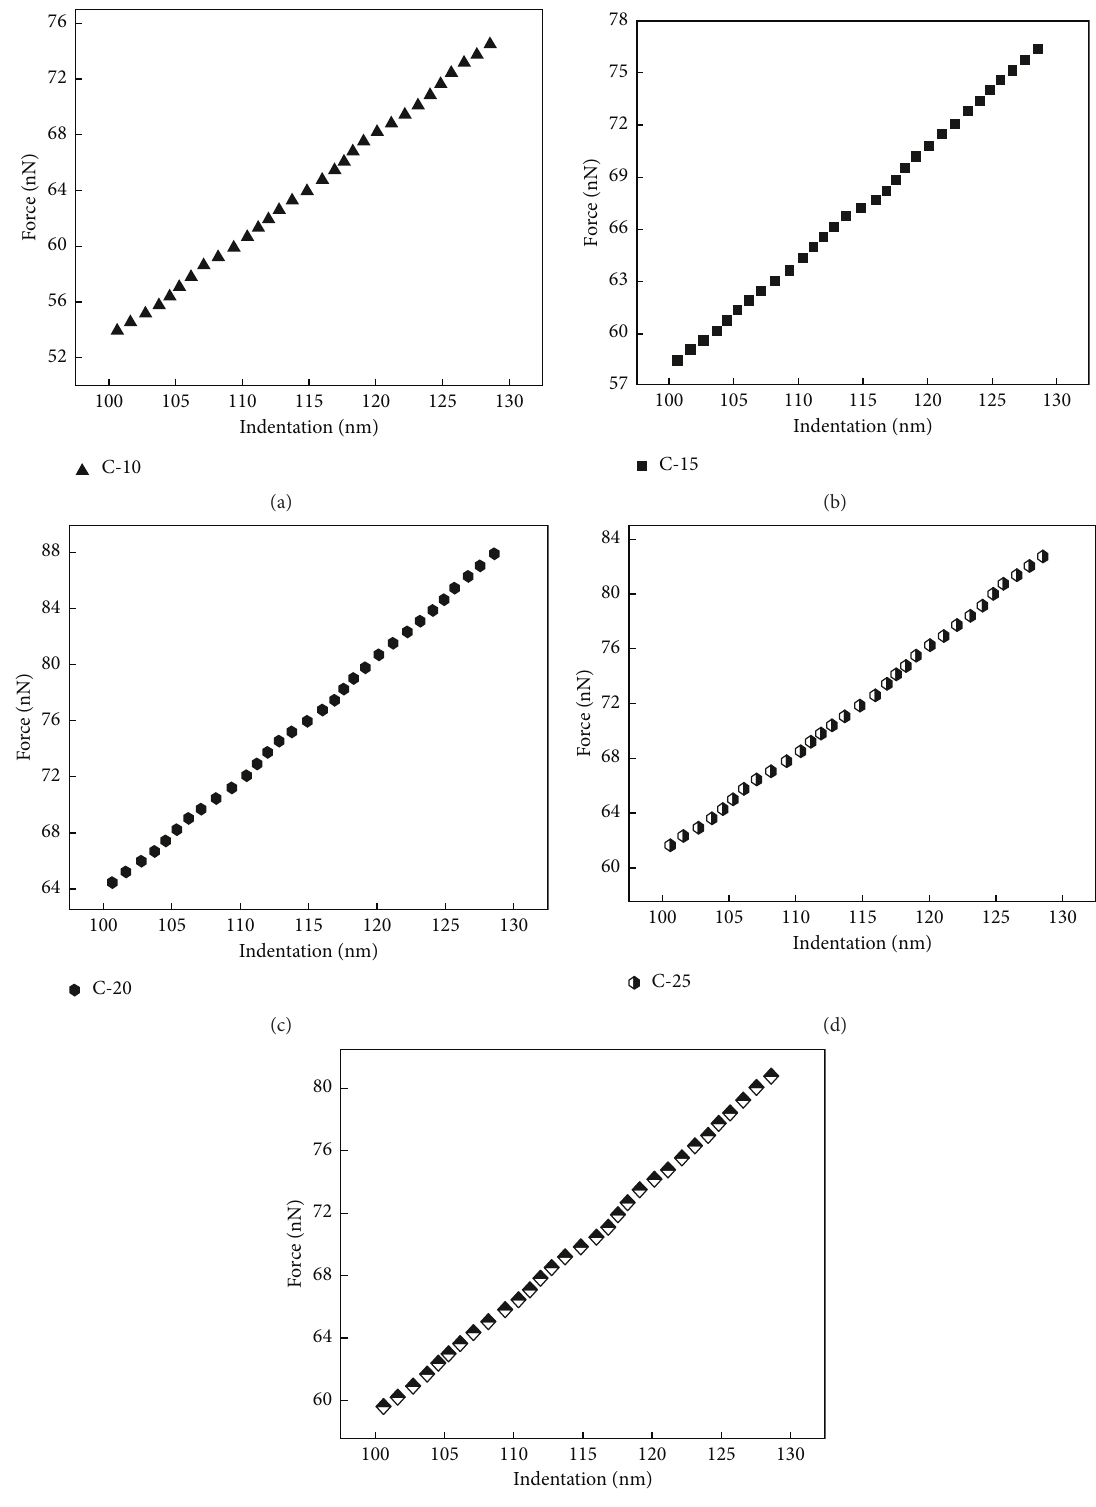
Figure 4: Force-indentation depth chart of (a) C-10, (b) C-15, (c) C-20, (d) C-25, and (e)